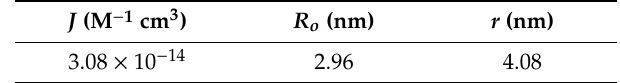
Table 3. FRET parameters for the interaction between 2,4-TZD and